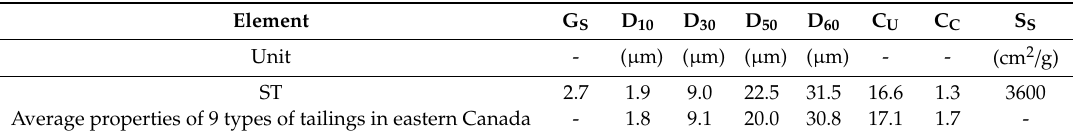
Figure 2. Test materials: ( a ) silica tailings (ST), ( b ) Ordinary Portland Cement Type I (PCI), ( c ) ferrous sulfate heptahydrate (FeSO4 · 7H2O), ( d ) monofilament polypropylene fibers (Adfil-Ignis). Table 2. Physical properties of the